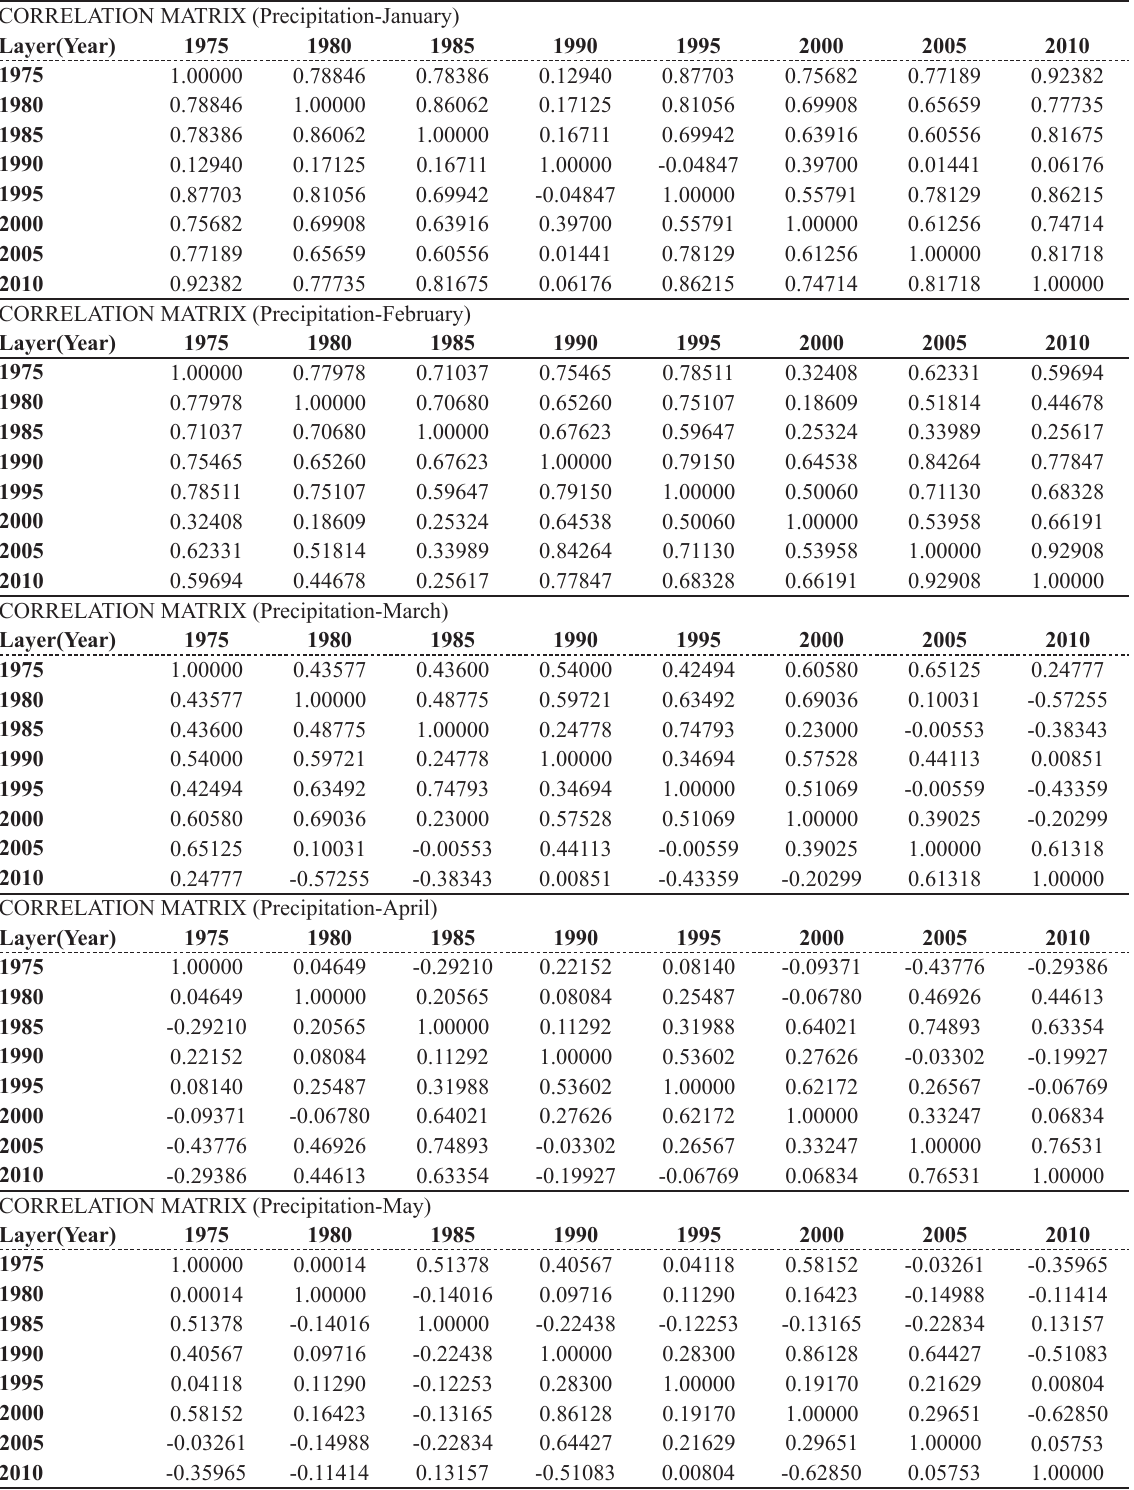
correlation matrix for precipitation